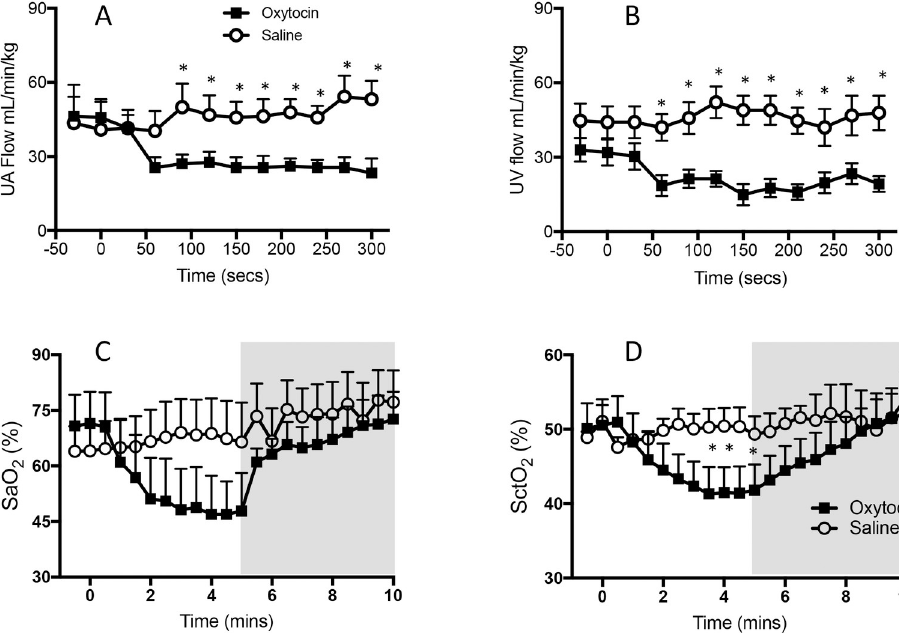
Fig 2. Changes in (A) mean ( ± SEM) umbilical arterial (UA) blood flow, (B) venous (UV) blood flow (C) arterial oxygen saturation (SaO 2 ) and (D) cerebral tissue oxygenation (SctO 2 ) levels in RU486 plus saline treated lambs (open cycles) and RU486 plus oxytocin treated lambs (closed squares). Samples were collected during the first 5 minutes